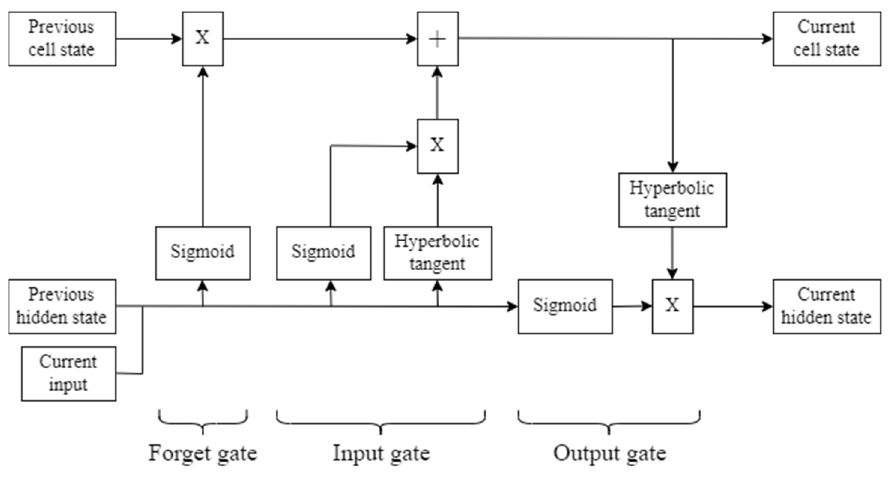
Figure 12. Mechanism of an LSTM cell.